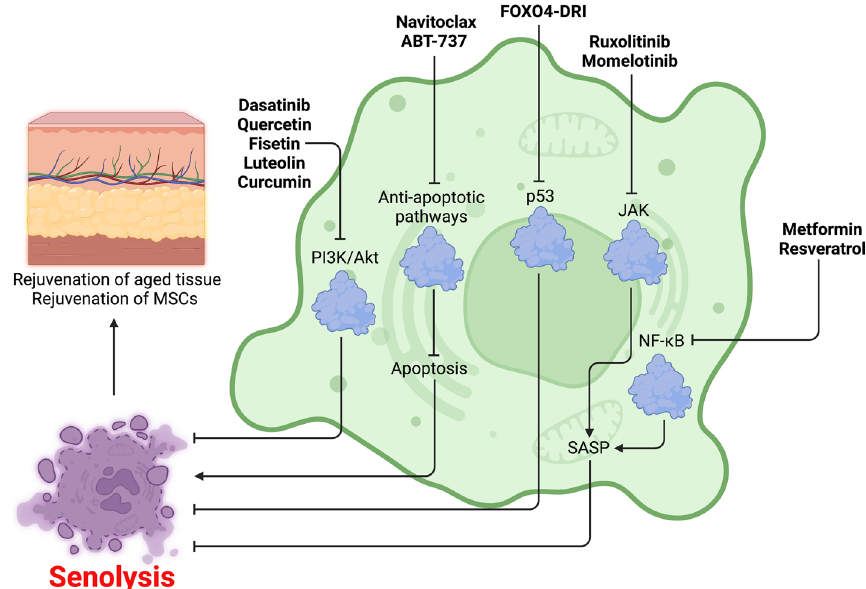
Fig. 8 Senolysis as a strategy to combat cellular senescence. Indicated senolytics induce cellular rejuvenation through targeting anti‑apoptotic pathways, and PI3K/Akt, p53, NF‑κB, and JAK signaling pathways. Activate, inhibit, senolytics